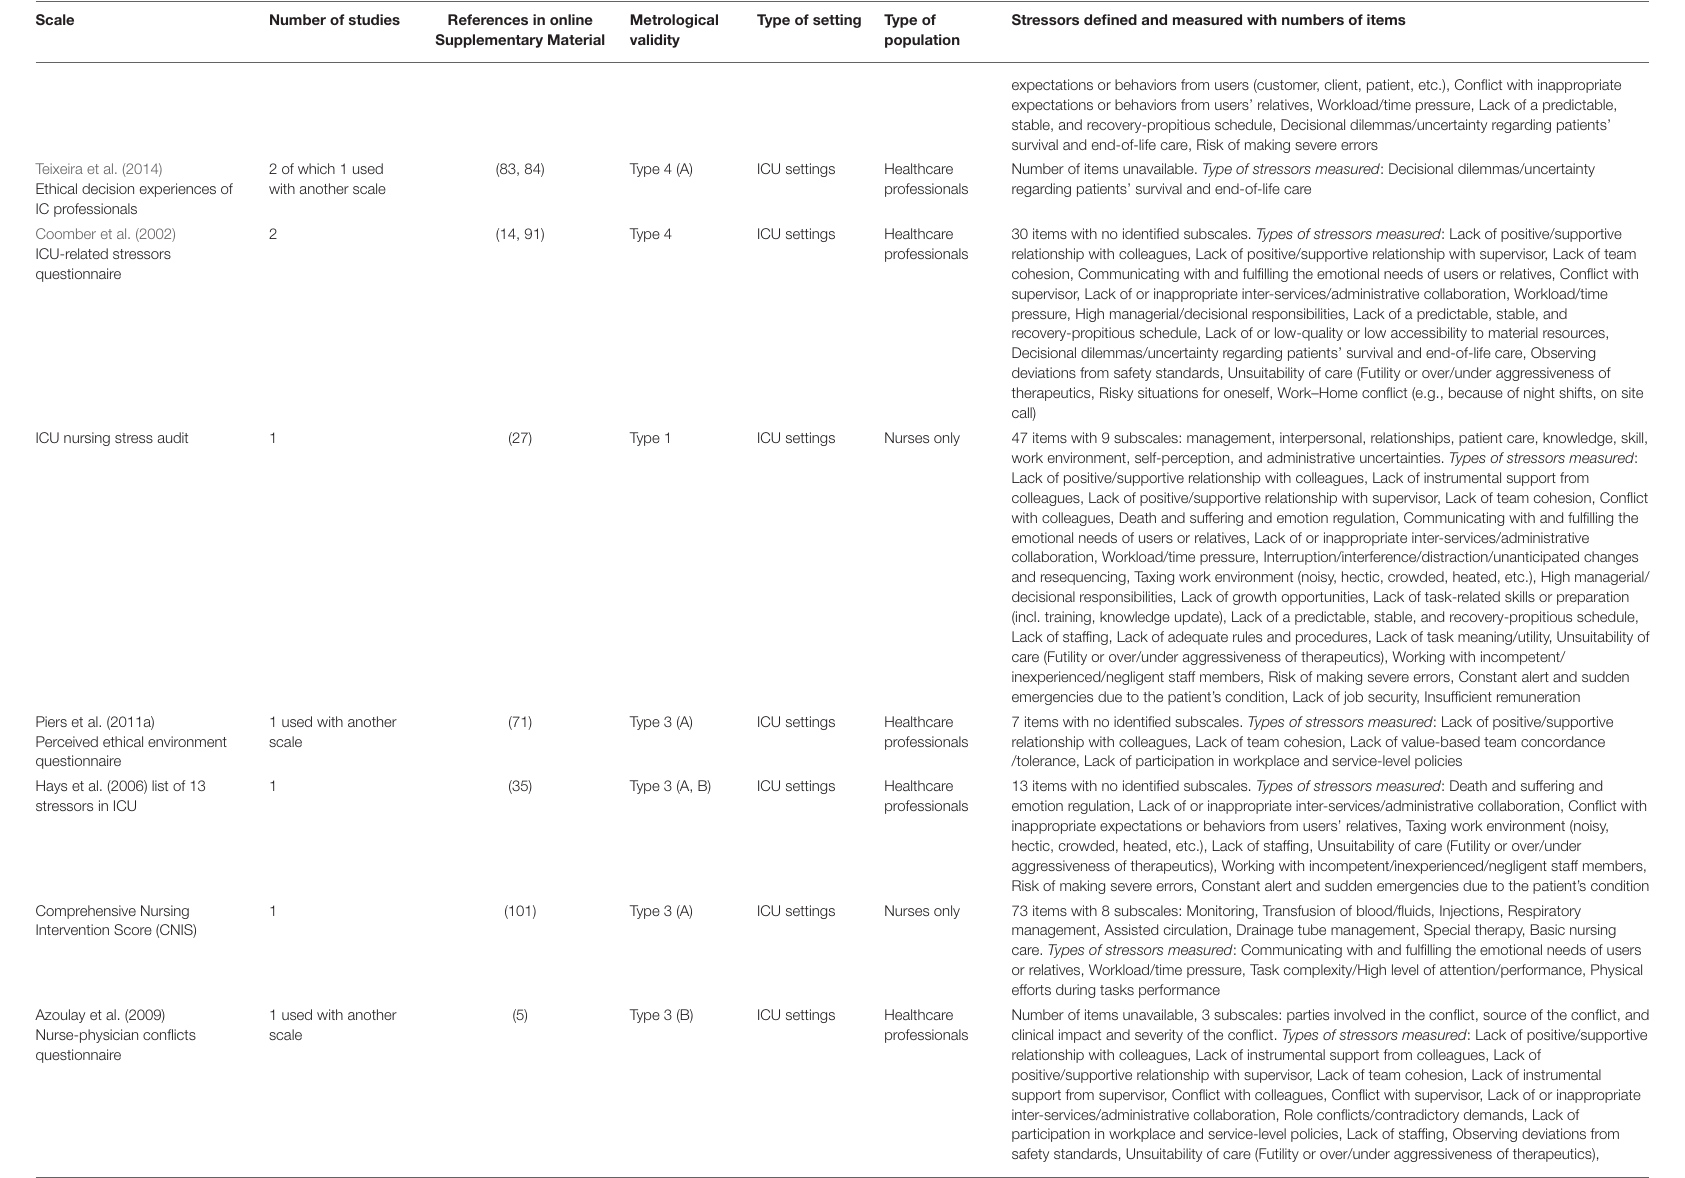
care. Types of stressors measured : Communicating with and fulfilling the emotional needs of users or relatives, Workload/time pressure, Task complexity/High level of attention/performance,